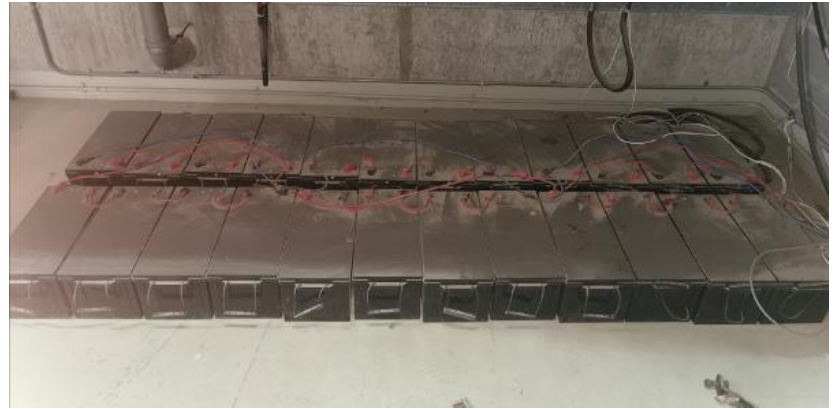
Figure 3. Battery bank used at the Smart Grid Lab. In contrast, Figure 4 shows the storage system used at the hybrid station, which consists of eight 12-Volt